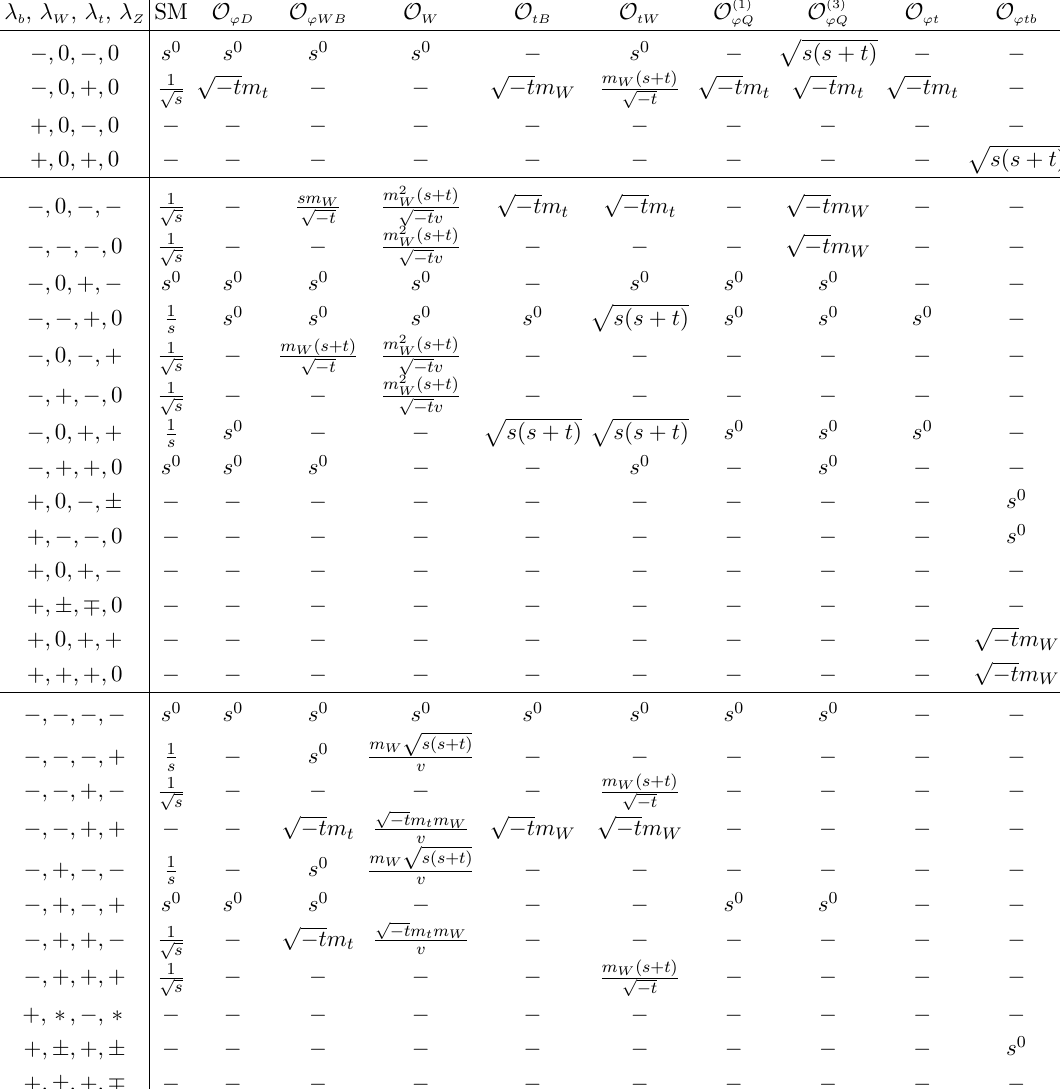
Table 10. Helicity amplitudes in the high-energy limit ( s Overall multiplicative factors are dropped and only the schematic energy dependence is retained for the SM contribution. Helicity entries marked by ‘ section 4.1.1 for a discussion of the